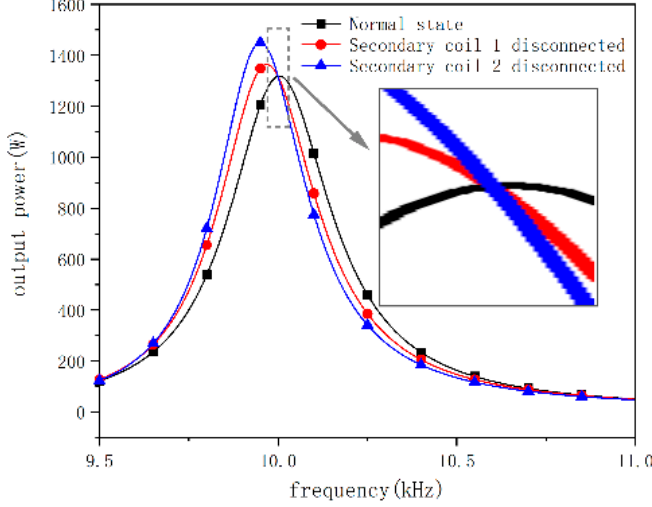
Figure 10. The output power of the secondary coil in normal and faulty Figure 10. The o utput power of the secondary coil in normal and faulty conditions.